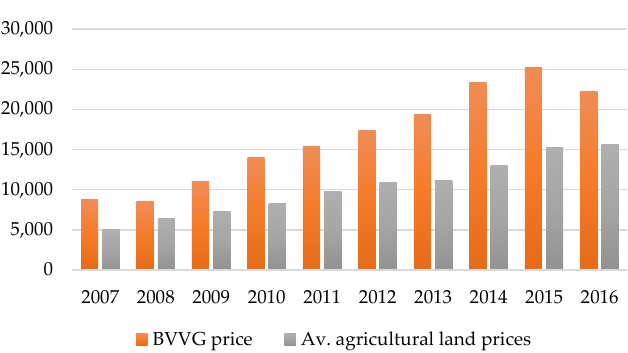
Figure 1. The development of annual BVVG ( Bodenverwertungs- und -verwaltungs GmbH ) and average agricultural land prices in Saxony-Anhalt, 2007 – 2016 [18 – 25].